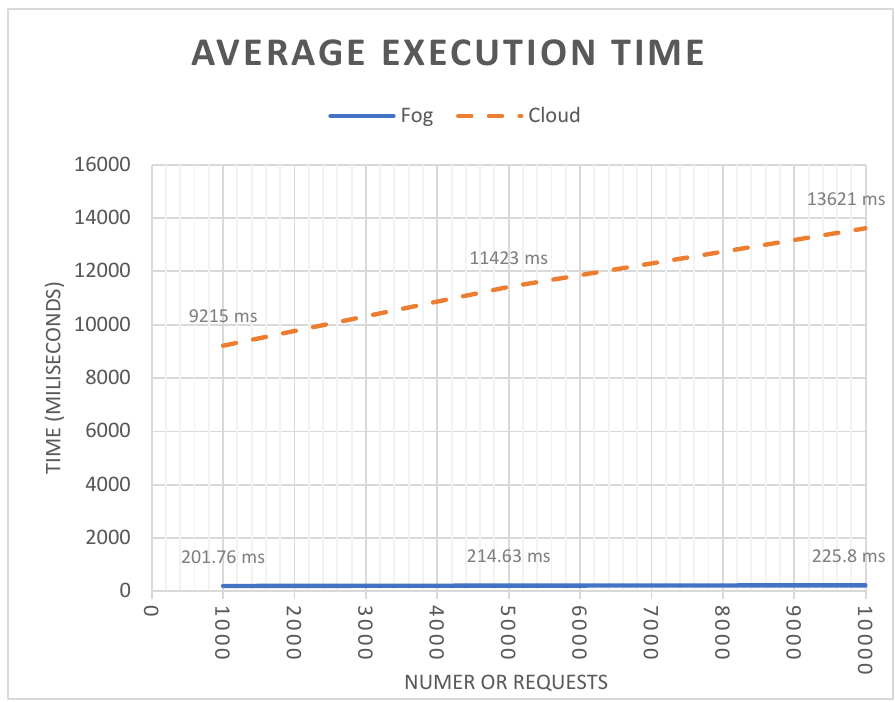
Figure 14. Average execution times of requests on Fog only and Cloud only for 1000, 5000, and 10,000 requests.